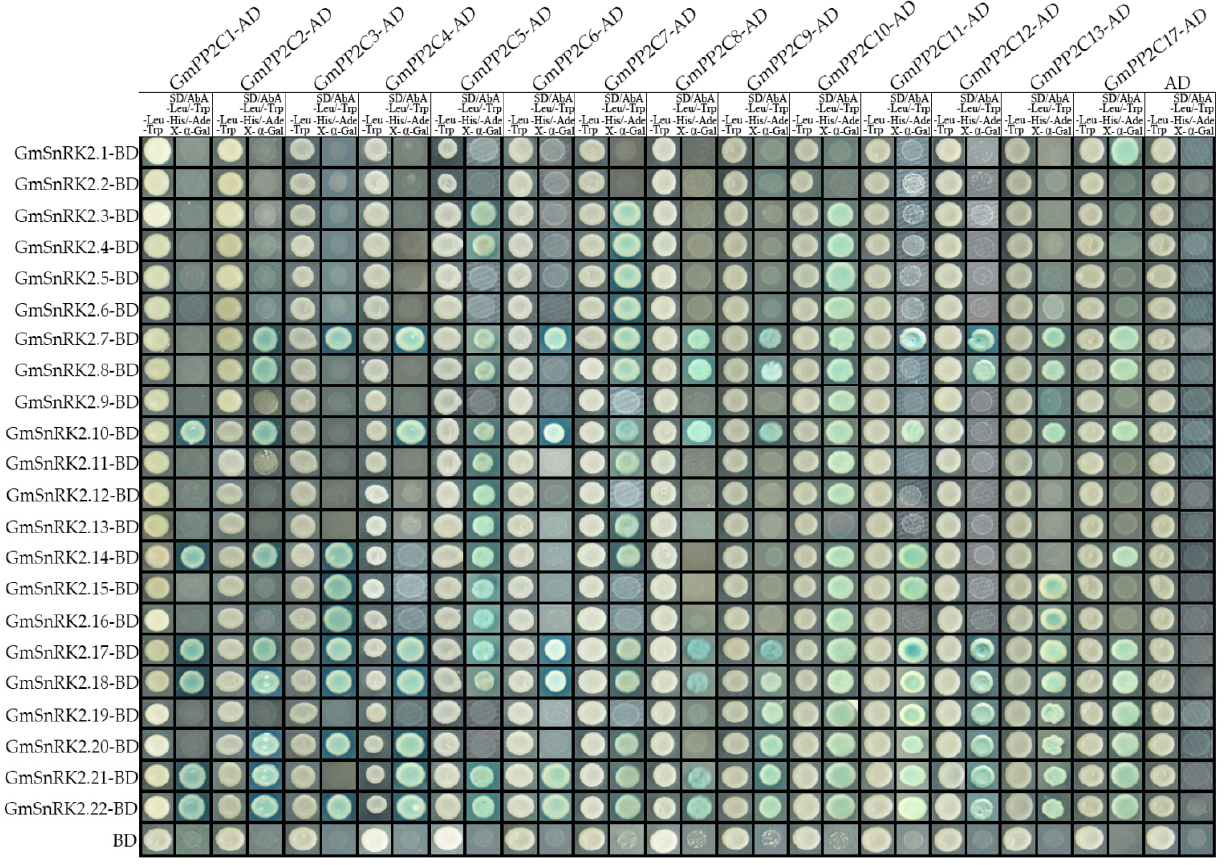
Figure 10. Physical interactions between GmPP2C-As and GmSnRK2s, determined using a Y2H system. A pGADT7 vector was used to express GmPP2C-As, and a pGBKT7 vector was used to express GmSnRK2s. The GmPP2C-AD and GmSnRK2-BD constructs were then co-transformed into yeast and selected on the basis of the ability of the yeast to grow on media lacking leucine (Leu) and tryptophan (Trp). The interaction was indicated by the ability of yeast to grow on selective media that included aureobasidin A (AbA) and X– α –Gal, but lacked Leu, Trp, histidine (His), and adenine (Ade). The interactions of the PacSnRK2-AD constructs with pGBKT7 were used as controls to test for yeast